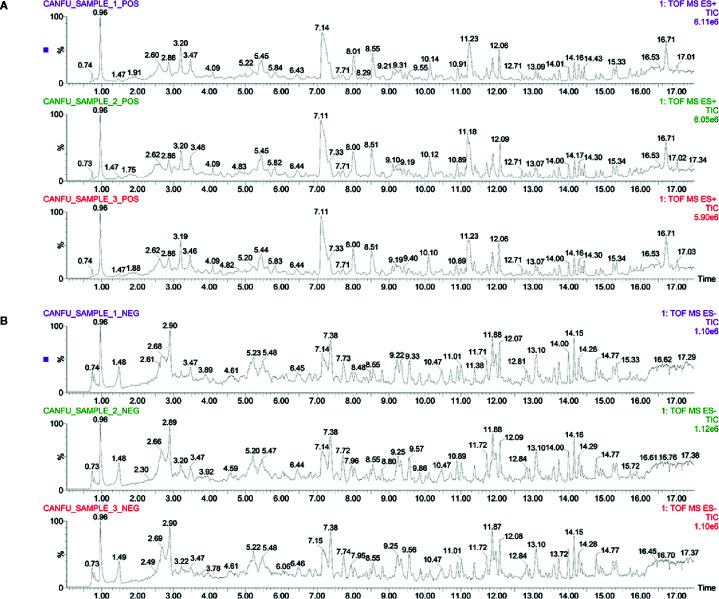
Identification of major components of SFH formula. Three parallel samples of SFH formula were detected by employing the UPLC–MS/MS system. Data were collected and proceeded by software Masslynx 4.1. The positive (A) and negative (B) ion chromatograms of SFH formula were shown as indicated.